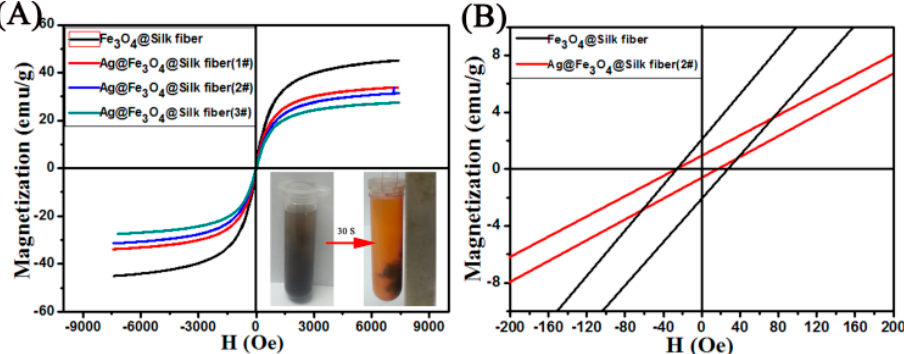
Figure 4. ( A ) Room temperature magnetic hysteresis loops for Fe 3 O 4 –silk fibers, Ag–Fe 3 O 4 –silk fibers